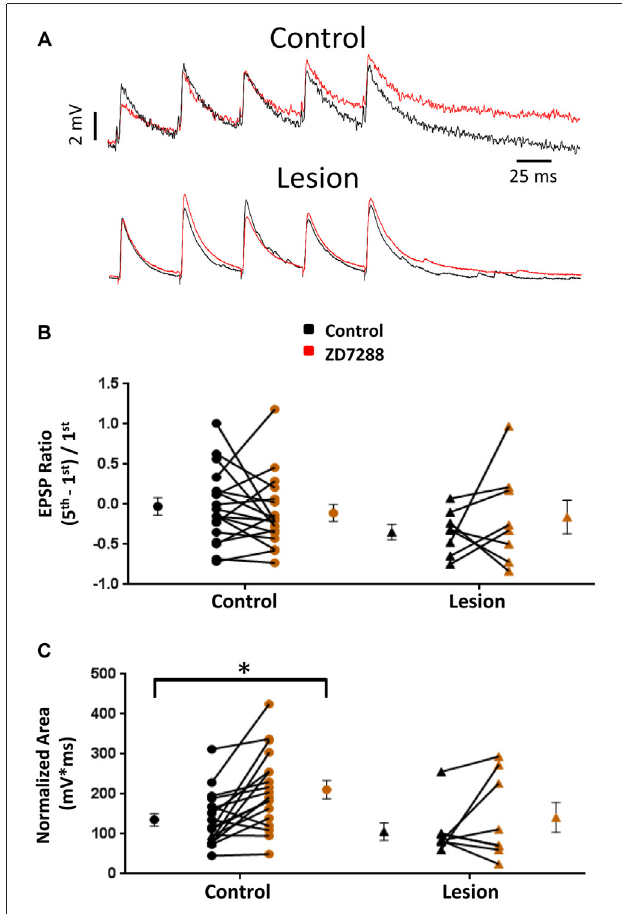
FIGURE 3 | Effects of HCN channel inhibition on EPSPs in L5 fast spiking interneurons. (A) Specimen records of trains of EPSPs evoked at 25 Hz before (black) and after (red) application of ZD7288 in control (top) and lesioned (bottom) animals. (B) HCN channel inhibition did not alter EPSP ratios in control or freeze lesioned animals. No significant difference was seen in pre-drug ratios between control and freeze lesioned rats. (C) HCN channel inhibition significantly increased the EPSP area in control but not freeze lesioned rats. No difference was seen in pre-drug EPSP area between control and freeze lesioned rats. Control: n = 18, Lesion: n = 8; ∗ p < 0.05, paired t -test. Error bars are mean ±